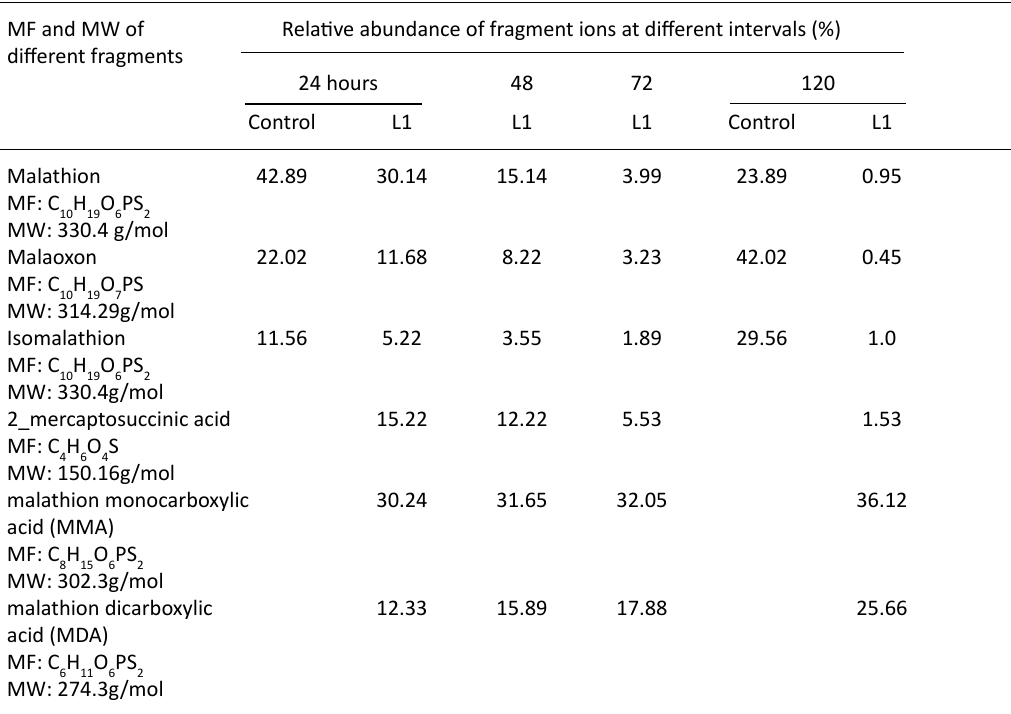
Table 1. The relative abundance of Malathion and its metabolites fragment ions in L1 treatment MF and MW of Relative abundance of fragment ions at different intervals (%) different fragments 24